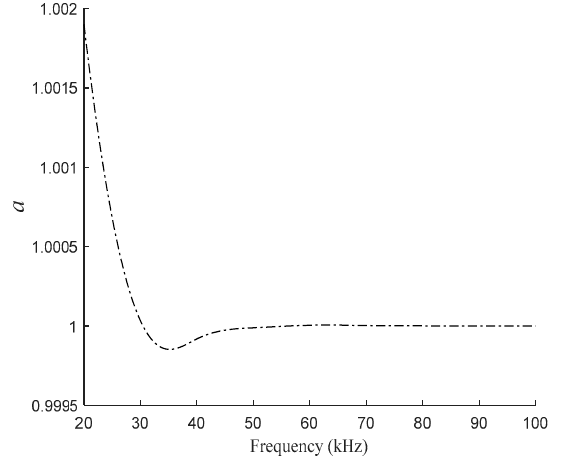
Figure 8. Variation of a with frequency.